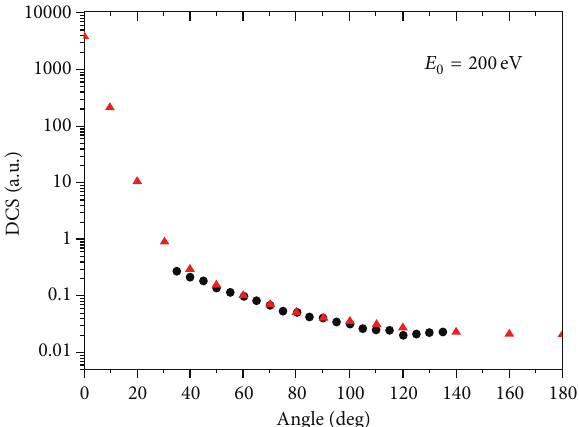
Figure 11: Present measurements ( ∙ ) of inelastic DCS of Helium for 2 1 P excitation level at 200 eV electron impact energy in comparison with the results of Fon et al. ( ) [4].